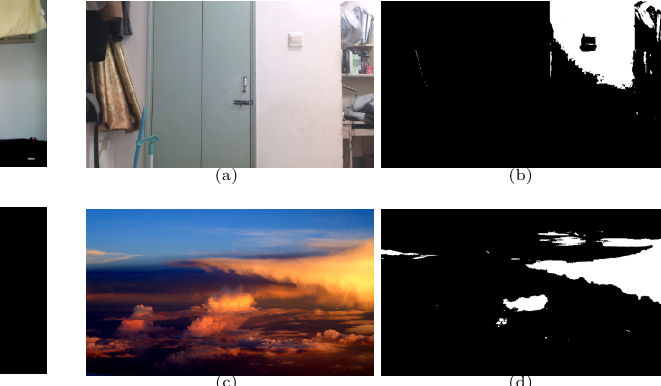
Fig. 1 (a) Pre-captured background. (b) One frame of the input video. (c) Binary foreground matte after graph-cut. (d) Foreground matte after filling holes.